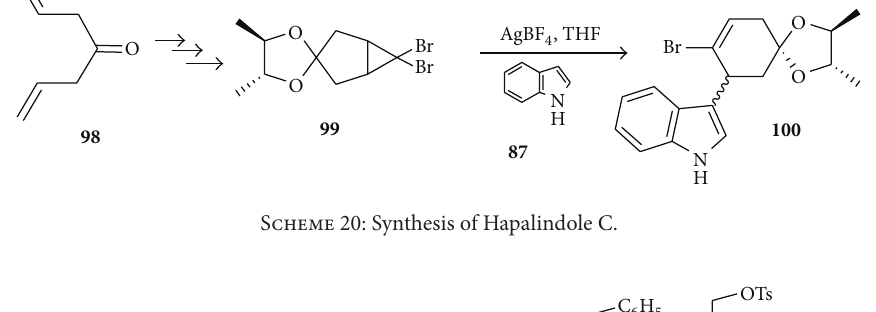
Scheme 20: Synthesis of Hapalindole C.